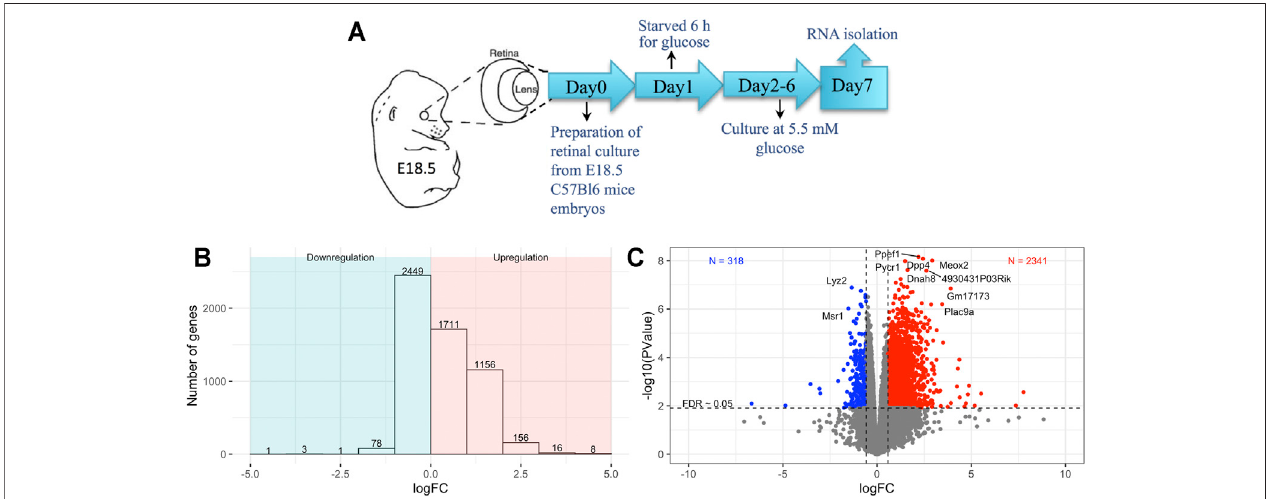
FIGURE1| (A) Schematicsofexperimentalsetup, (B) barplot showingthenumber ofdifferentially expressed genesfordifferentlog-fold-changebins, (C) volcano plotshowingthevariationofsigni fi cancewithlog-fold-change;blueandredcolorsshowdownregulatedandupregulatedgenesinthestarvedconditionswithalog-fold- change greater than 50% between conditions and FDR <